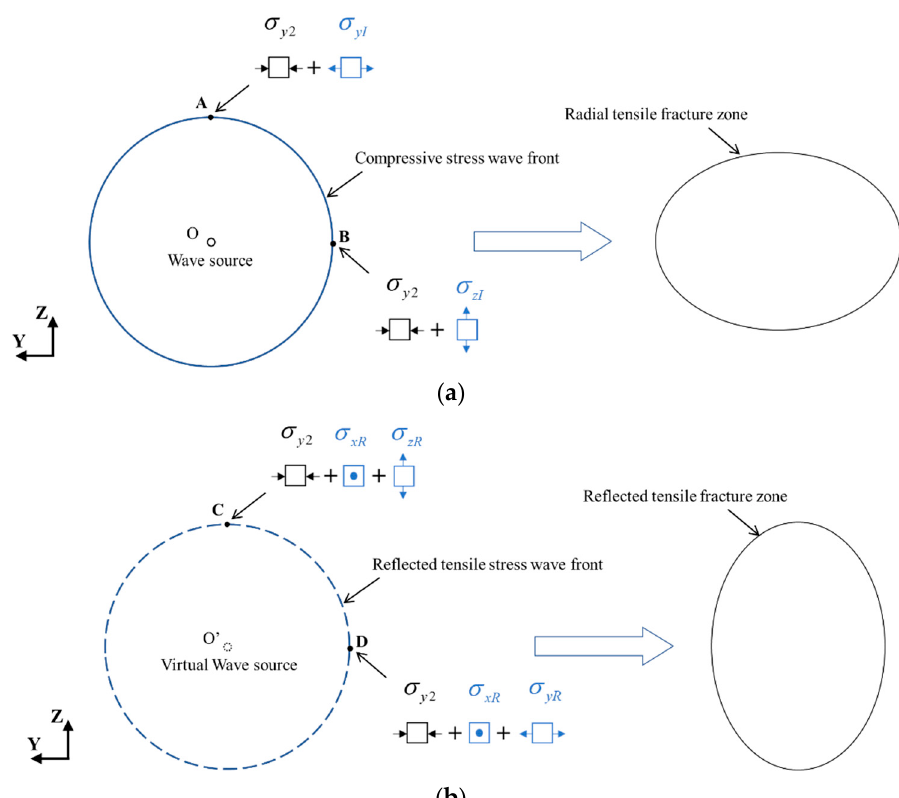
Figure 8. Damage contours at cut Z1 and crater volumes for each burden under different P2: ( a ) damage contours; ( b ) crater volumes.